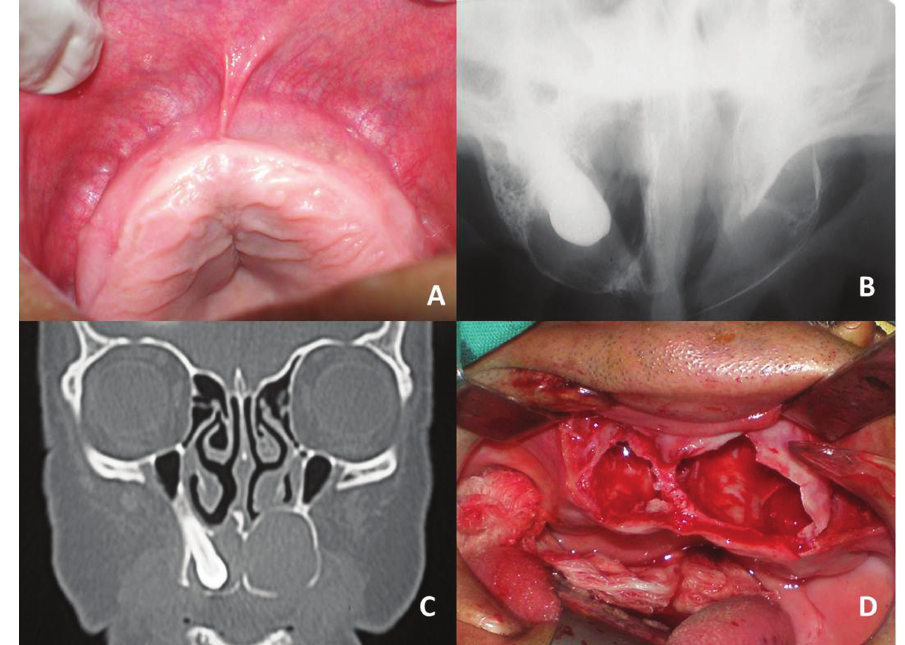
Figure 1 A, Palatal bilateral swelling. B, Radiolucent area with expansion of the buccal cortical on the left side, and a canine tooth associated with a radiolucent area on the right side. C, Hypodense areas in the coronal view of computed tomography. An elevation in the left nasal fossa floor is visible. D, Surgical